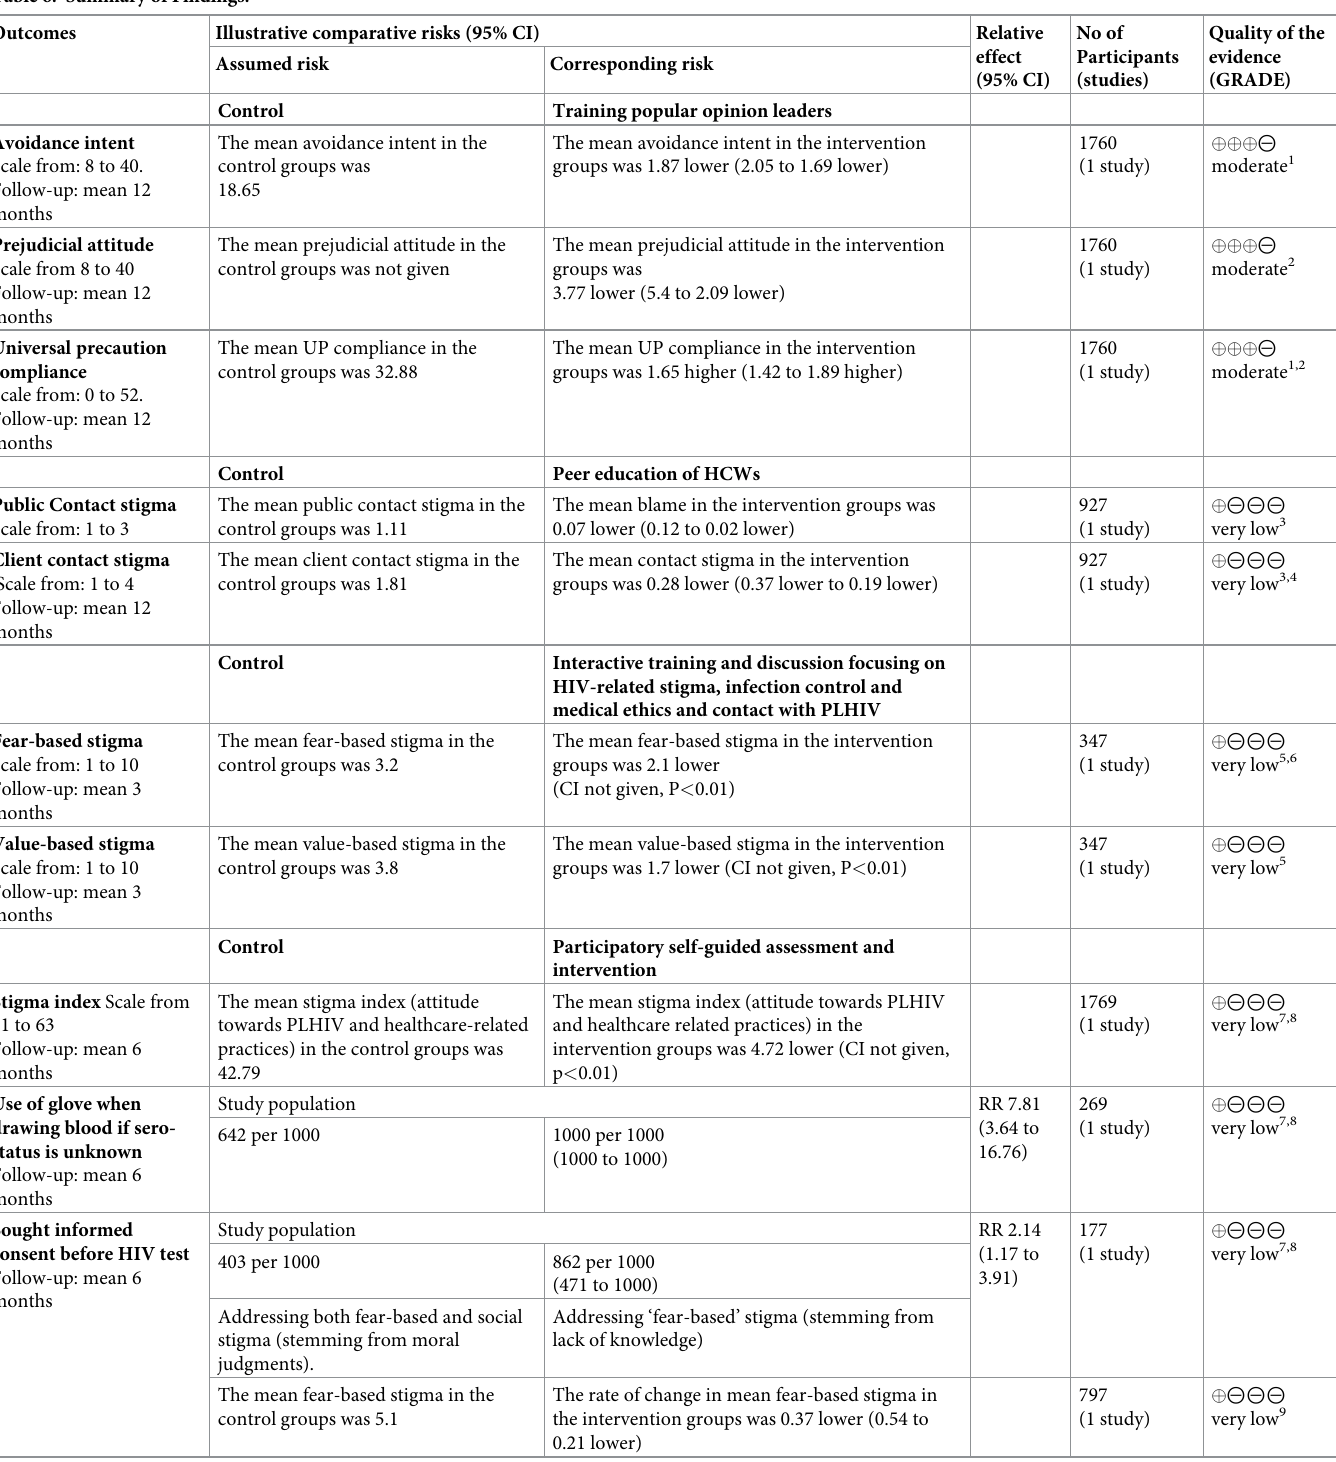
Table 6. Summary of Findings. Outcomes (GRADE)Assumed risk Corresponding risk Control Training popular opinion